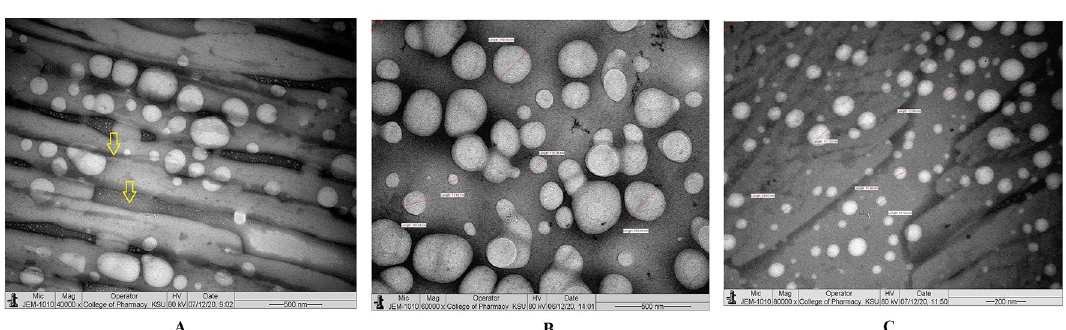
Figure 6. Transmission electron microscope study. ( A ) Morphology of lyophilized CCNP under ×40,000 magnification. The yellow colour aero mark indicating fine lower size nanoparticles embedded in the mannitol powder which is representing the background. ( B ) Morphology of lyophilized CCNP under ×60,000 magnification with size measurement. ( C ) Morphology of lyophilized CCNP under ×80,000 magnification with size